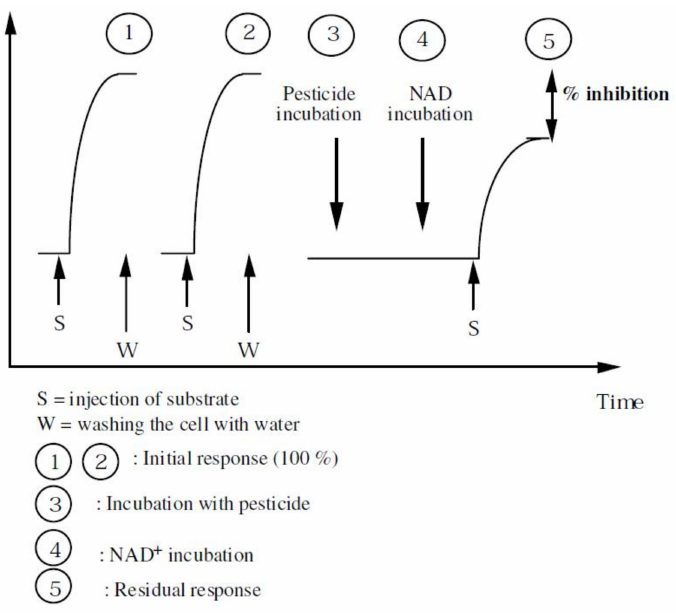
Figure 8. Typical experimental protocol for an amperometric biosensor for DTF based on aldehyde dehydrogenase. Reproduced from [78], by